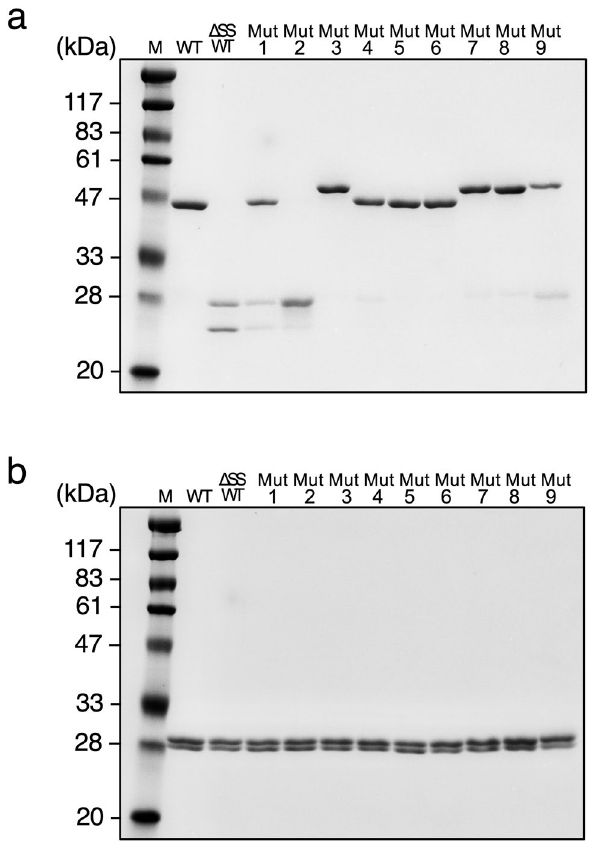
Figure 2. SDS-PAGE analysis of purified intermolecular SS mutants. The samples were analyzed by 12% SDS- PAGE under ( a ) non-reduced condition and ( b ) reduced condition. Lane M: protein markers. Lane 1: WT, Lane 2: ΔSSWT, Lane 3: Mut1, Lane 4: Mut2, Lane 5: Mut3, Lane 6: Mut4, Lane 7: Mut5, Lane 8: Mut6, Lane 9: Mut7, Lane 10: Mut8, Lane 11: Mut9. The gels were stained with SimplyBlue safe stain (Invitrogen) and were then imaged using iBright FL1000 (Thermo Fisher